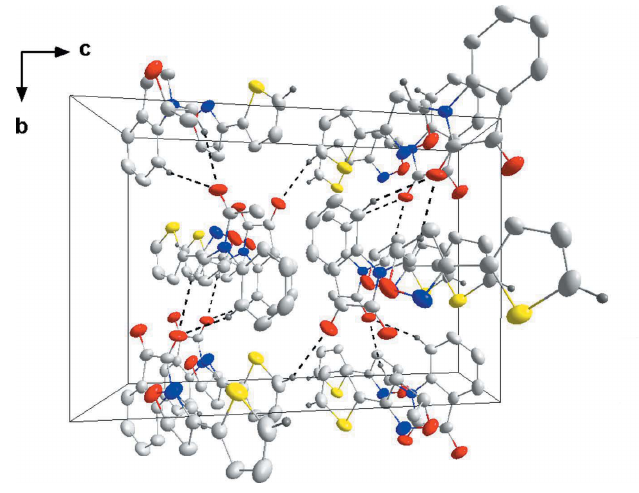
Figure 2 The partial view along the a axis of the crystal packing of the title compound. The hydrogen bonds are shown as dashed lines (see Table 1).